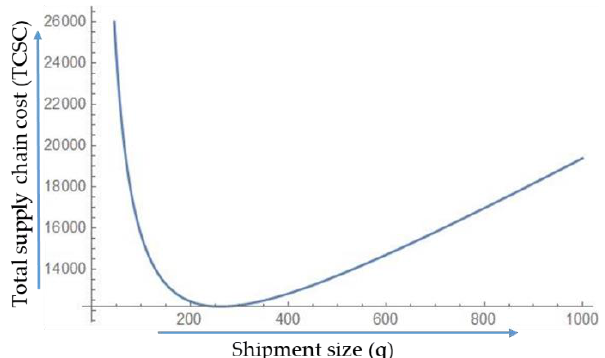
Figure 3 . Relationship between total cost and shipment size.